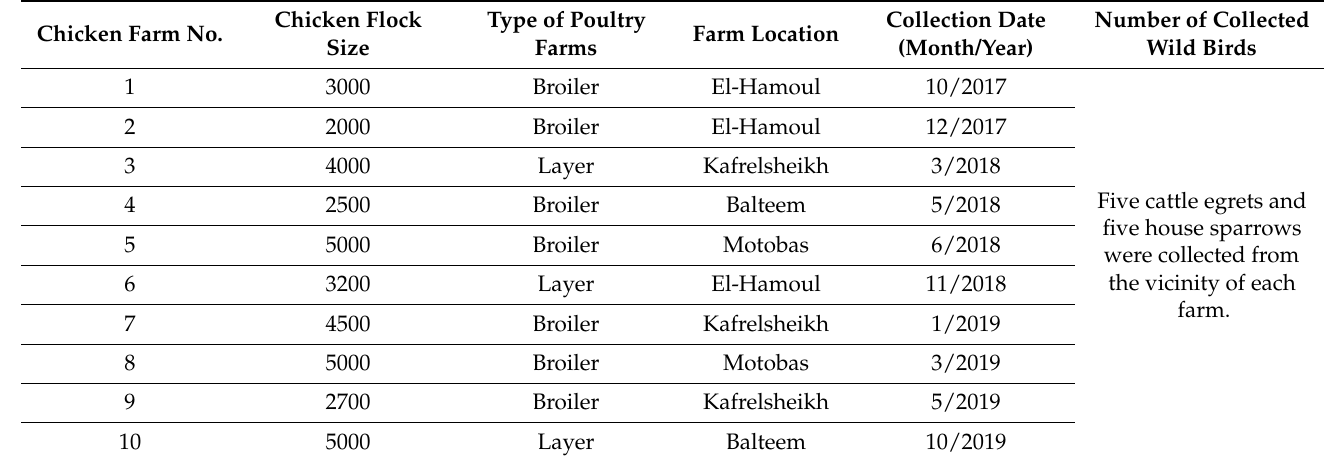
Table 1. Details of collected samples, including chicken flock size, type of poultry farm, location of farms, collection date, and number of collected wild birds. Chicken Farm